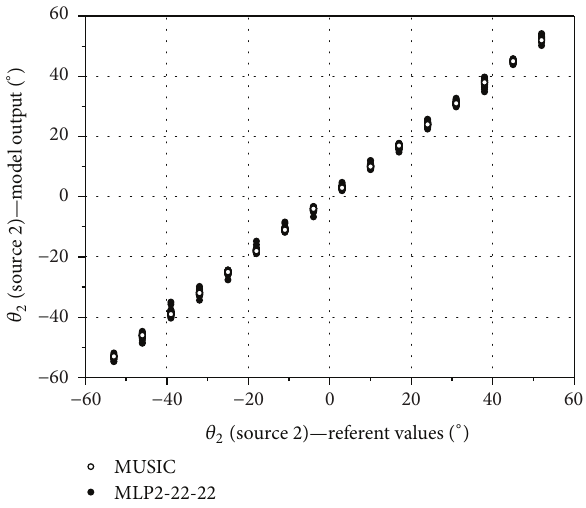
Figure 9: Scattering diagram of chosen MLP-DoA 3 network (MLP2-22-22) and the MUSIC model for output 2 (source 2) obtained by simulation on the test set (Case 𝑠 = 3 ).